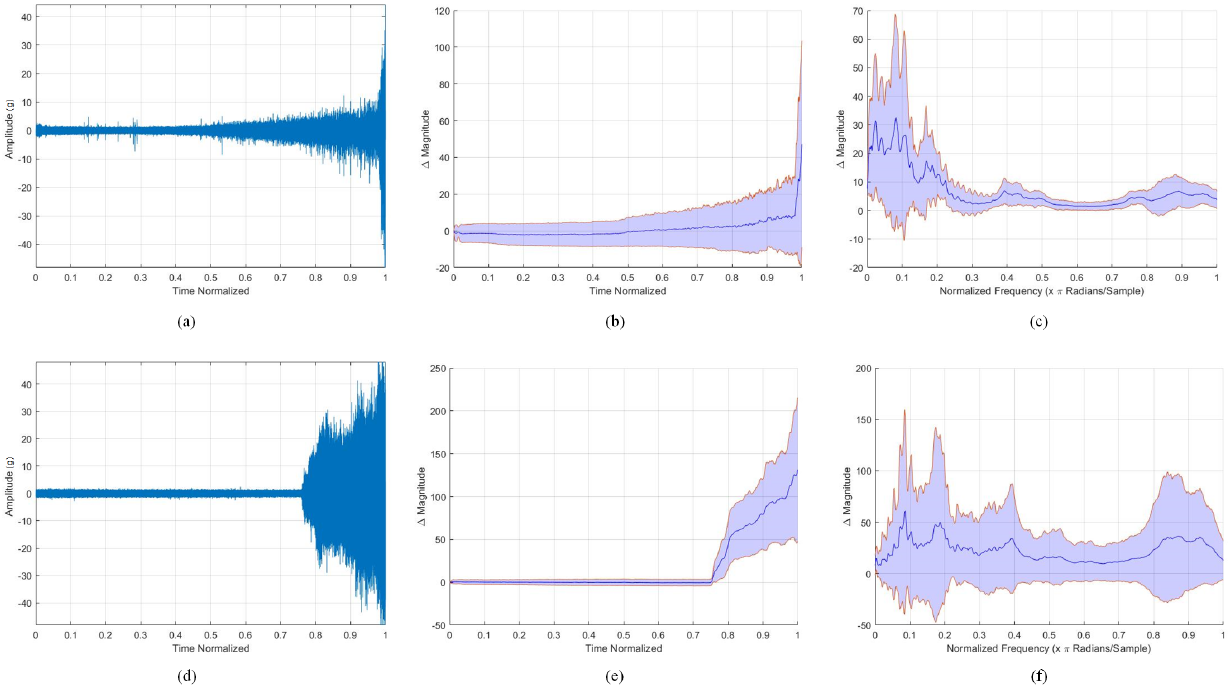
Figure 3. Plots ( a , d ) illustrate the time series vibration signals of bearings S. 01 and S. 04, respectively. Panes ( b , e ) show the variance of the total frequency amplitude values of each signal acquisition over time. The shaded error bar illustrates the mean ± one standard deviation. Panes ( c , f ) show the variance of the frequency variance of bearing S. 01 and S. 04 throughout the entire ageing process. The shaded error bar illustrates the mean frequency spectral amplitudes ± one standard